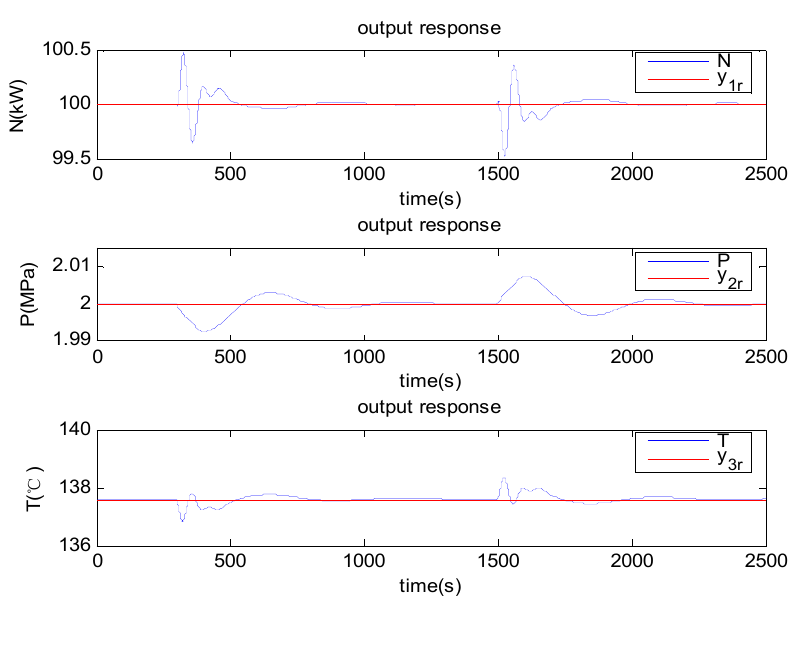
Figure 10. Responses of controlled